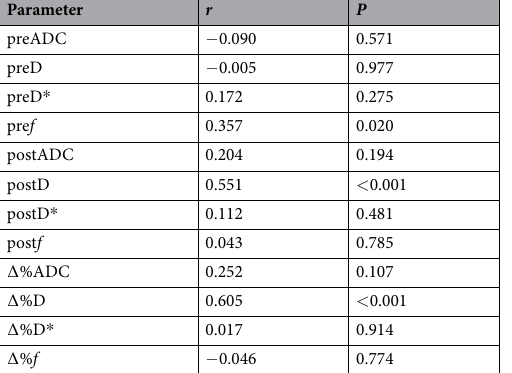
Table 2. Correlation between TRG score and the IVIM-DWI parametric values. TRG,tumor regression grade; IVIM-DWI, intravoxel incoherent motion diffusion-weighted imaging; ADC, apparent diffusion coefficient; D, pure diffusion coefficient; D * , pseudo-diffusion coefficient; f , perfusion fraction.